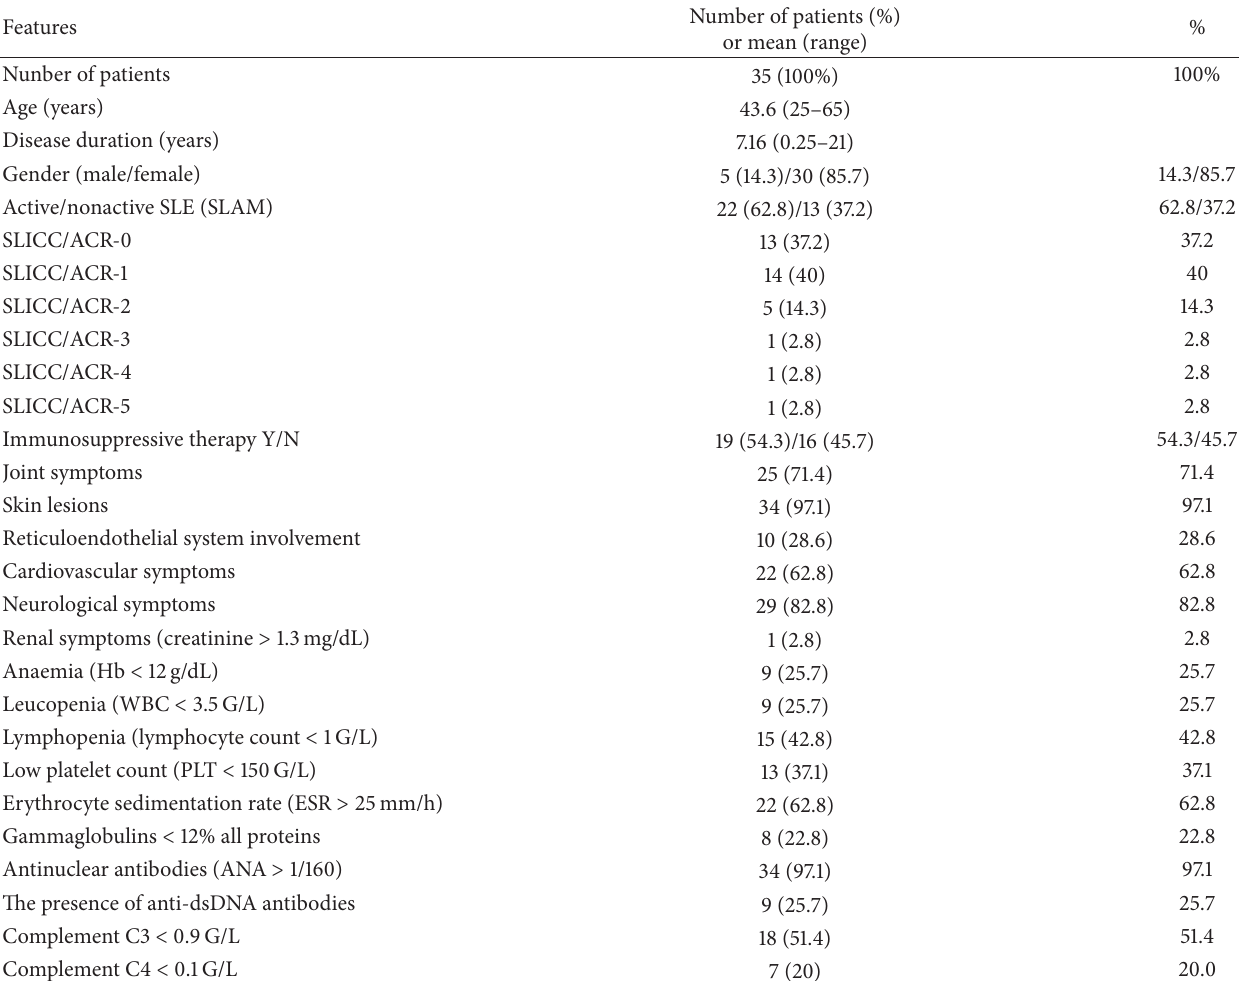
Table 1: Clinical and laboratory characteristics of the study